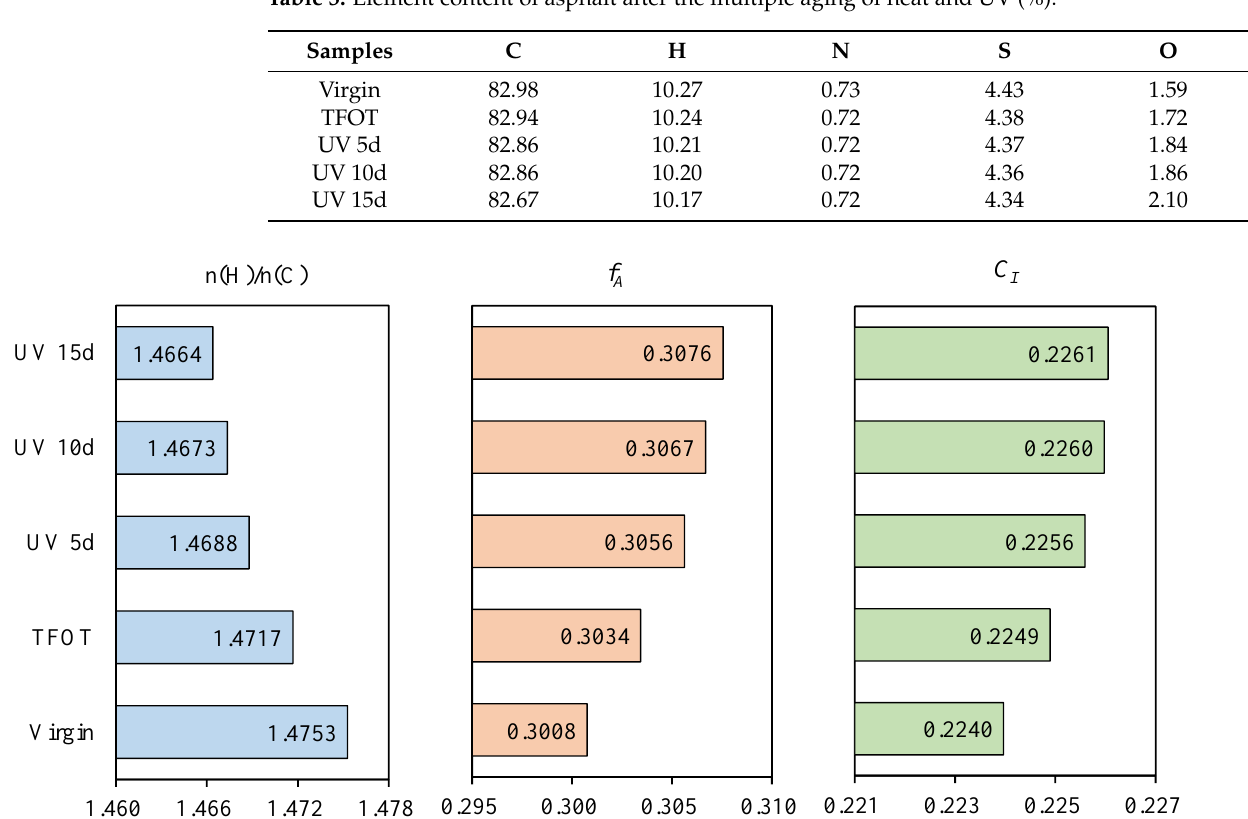
Table 3. Element content of asphalt after the multiple aging of heat and UV (%).